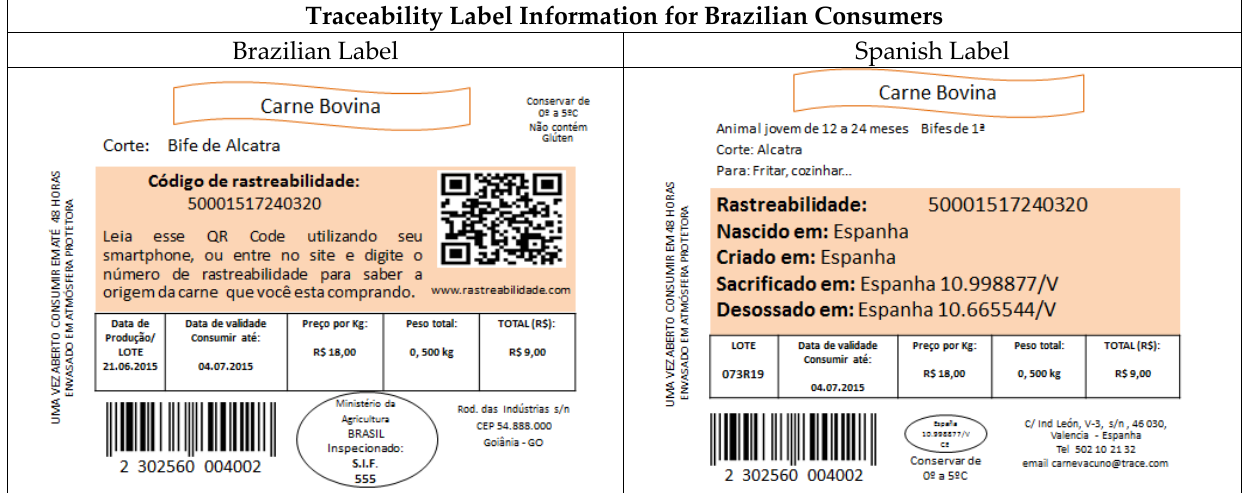
Figure A2. Information contained within the colored card: Código de rastreabilidade: (Traceability number); QR code; Rastreabilidade: (traceability number); Nascido em: (Animal birthplace); Criado em: (Animal fattening location); Sacrificado em: (Slaughterhouse); Desossado em: (Cutting and boning room).